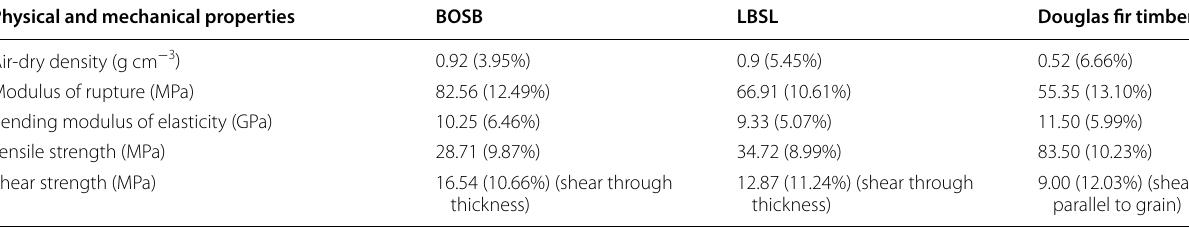
Values in parentheses are coefficient of variation